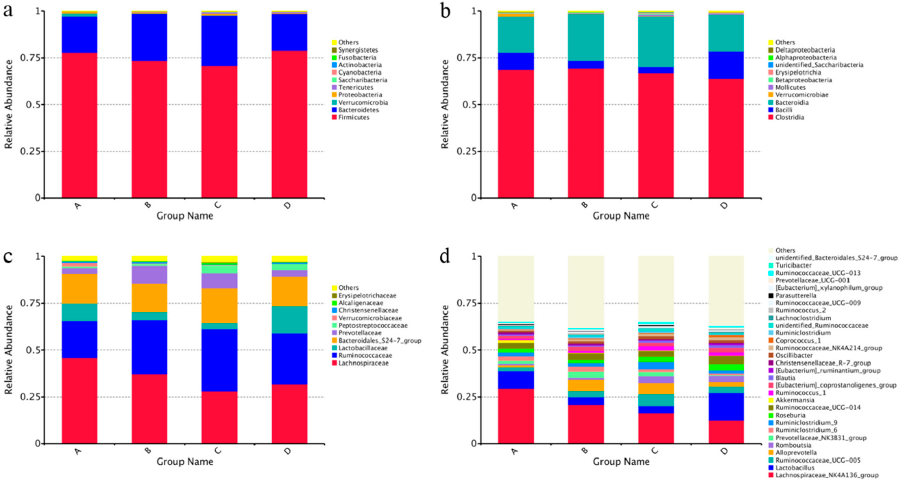
Figure 6. Caecal microbiota structure between groups ( n = 4 in each group). Note: A: control group with standard diet (0.4% NaCl); B: high-salt diet (4.0% NaCl); C: high-salt diet (4.0% NaCl) with 0.5% betaine; D: high-salt diet (4.0% NaCl) with 1.0% betaine; ( a ) phylum level; ( b ) class level; ( c ) family level; ( d ) genus